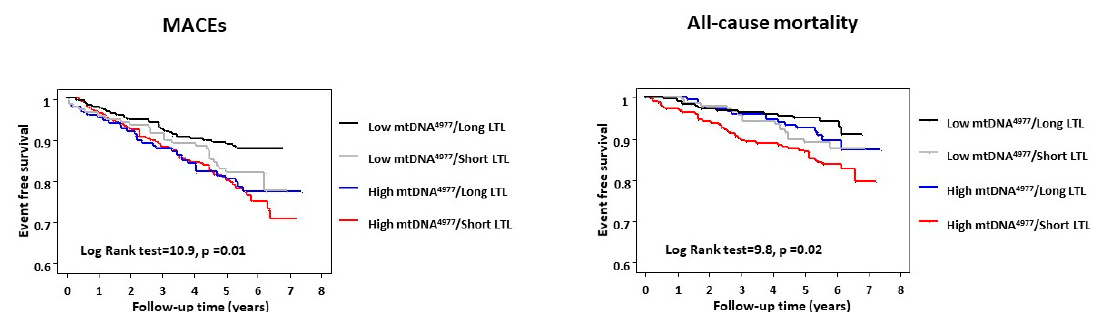
Figure 2. Kaplan–Meier plot of major adverse cardiovascular events (MACEs) and all-cause mortality for patients stratified in four groups according to LTLs and mtDNA 4977 deletion levels. Short LTL = LTL of < median value; Long LTL = LTL of ≥ median value; High mtDNA 4977 deletion = mtDNA 4977 deletion level of > median value; Low mtDNA 4977 deletion = mtDNA 4977 deletion levels of ≤ median value.